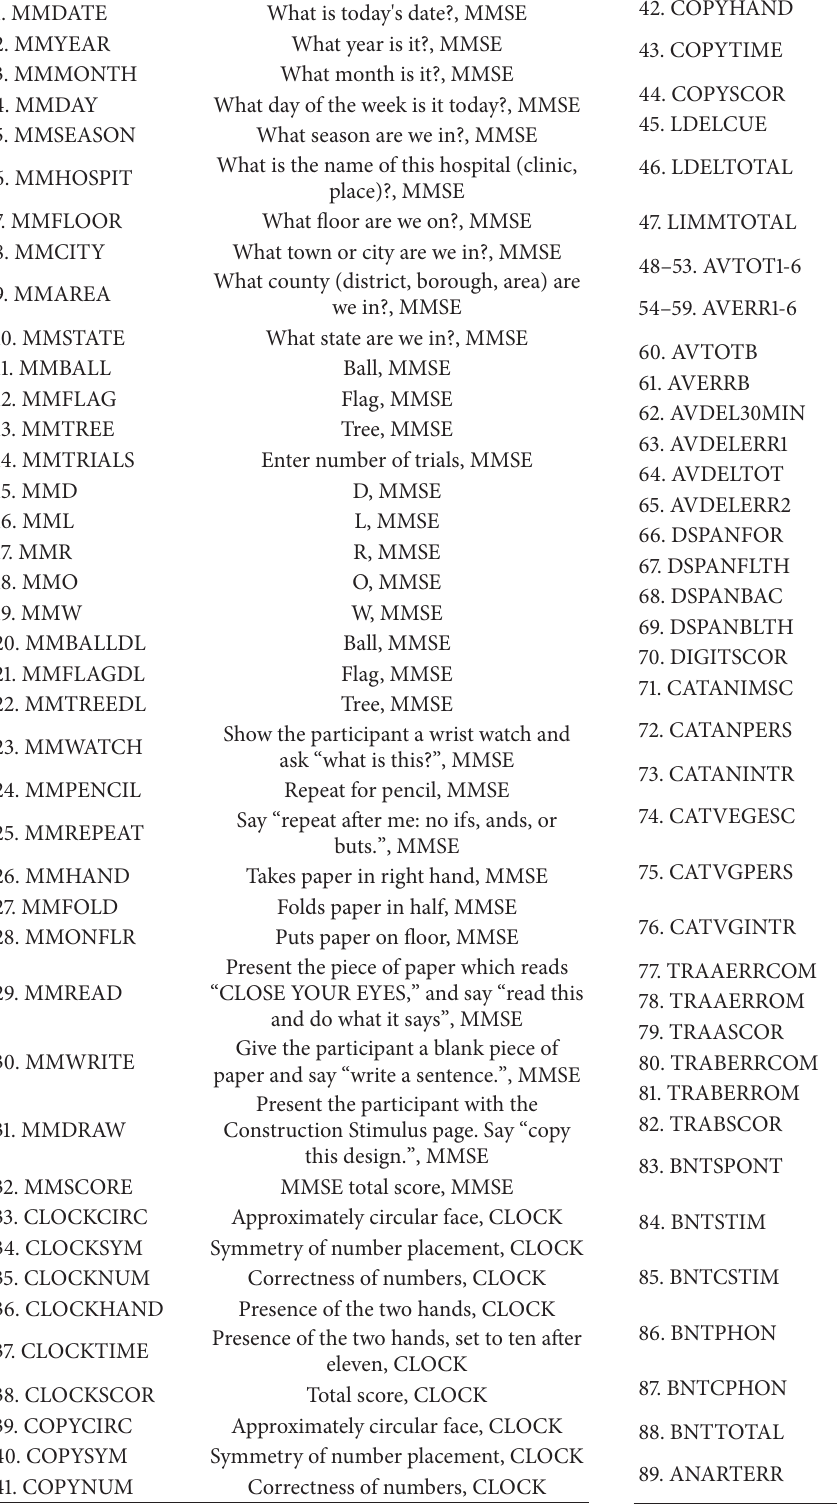
Table 1: List of neuropsychological measures used as features.